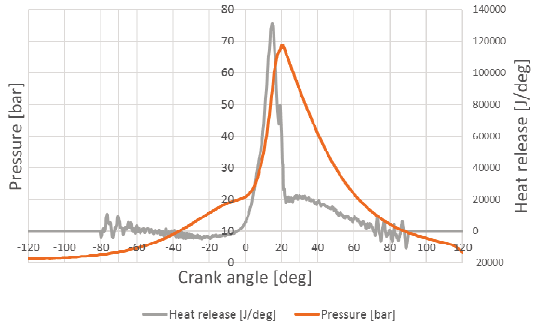
Fig. 11. Preliminary results from PAMAR-4 engine – pressure [Pa] vs crank angle [deg]